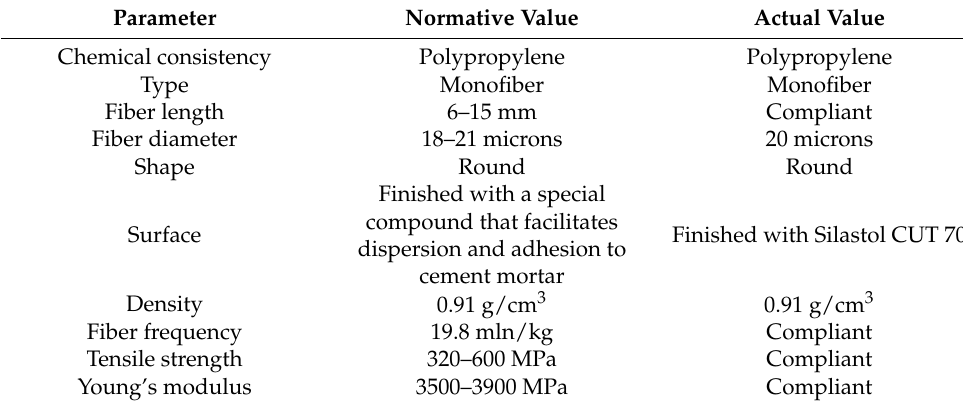
Table 2. Technical characteristics of polypropylene